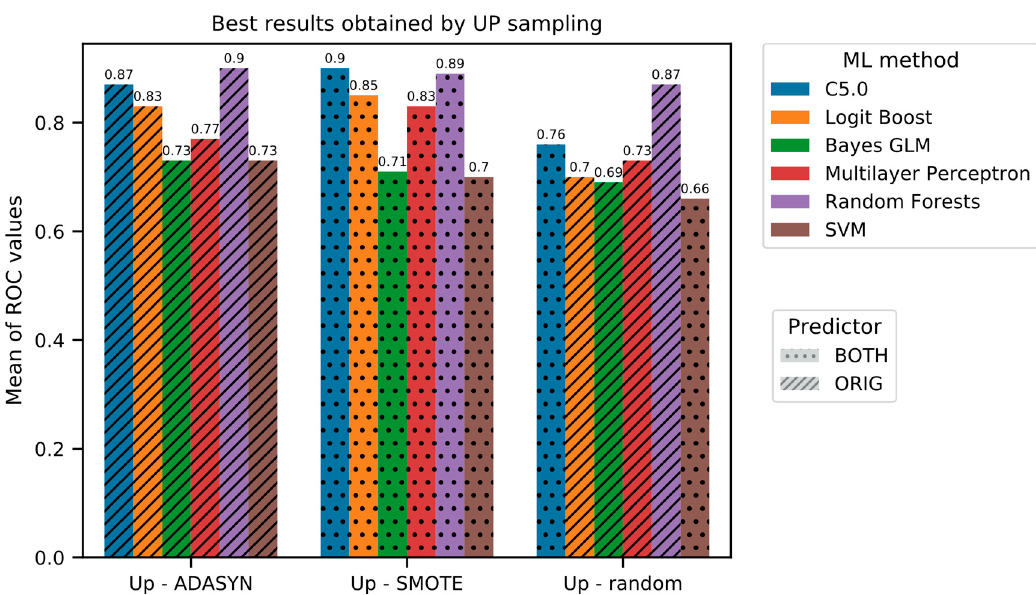
Figure 2. Highest mean accuracy values in down-sampling subset, corresponding to each ML method. Each color bar represents the different classification models. The texture of the bar represents the input predictor from which each model has been generated. The two different down-sampling methods are represented grouped in the X axis.